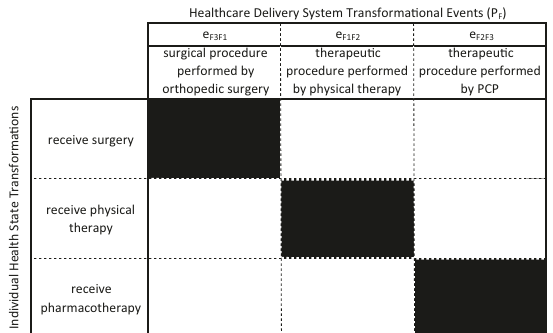
Figure 16: Individual Transformation Feasibility Matrix Λ 𝐹 of the chronic diabetes example.